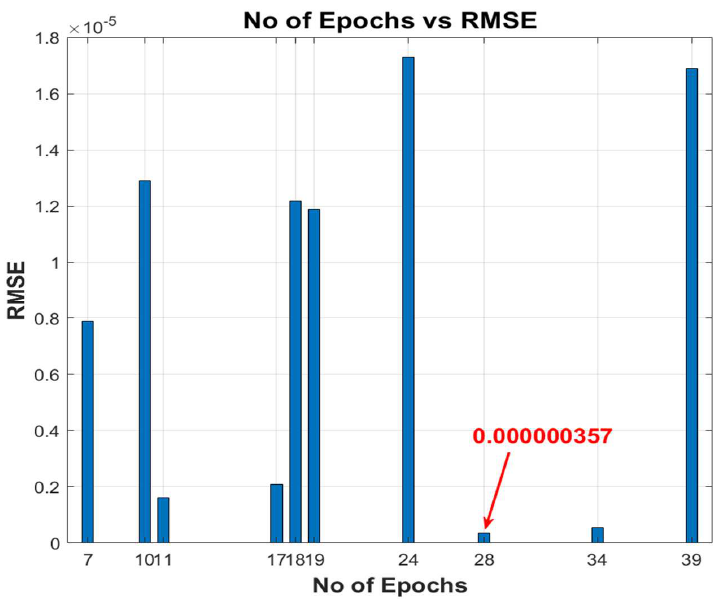
Figure 6. Number of epochs vs. RMSE. A performance plot of the RMSE value and the number of epochs vs. the network